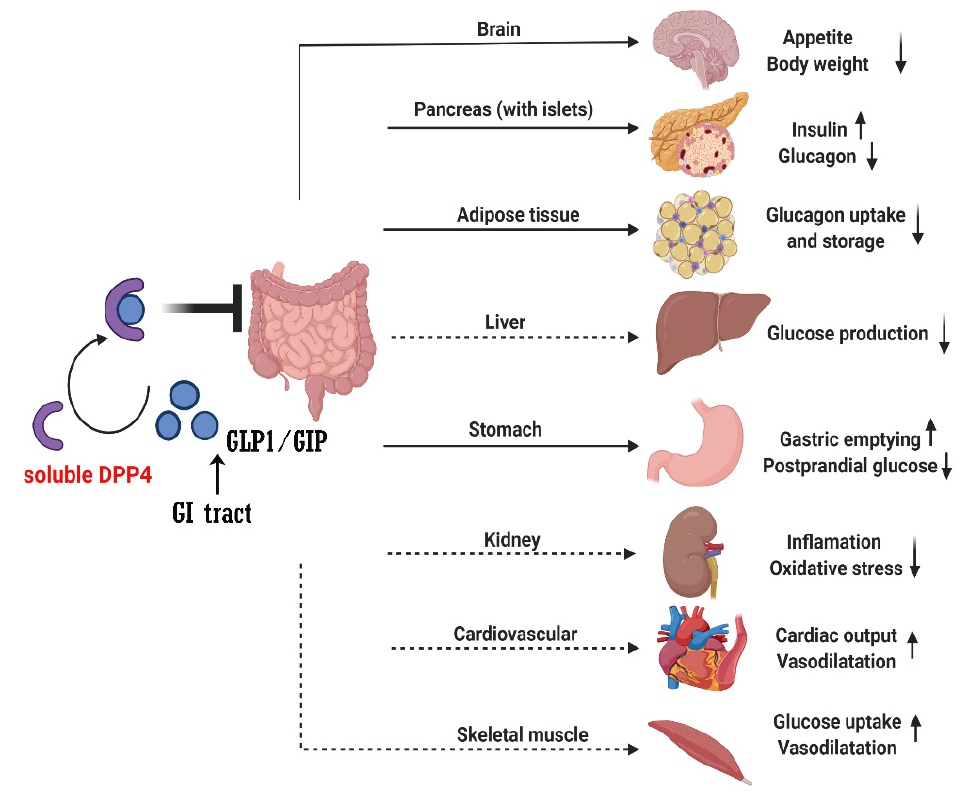
Figure 1. The action of DPP4 degrades the GLP1 and GIP. GI: gastrointestinal; GIP: glucose-dependent insulinotropic polypeptide, GLP1: glucagon-like peptide-1, DPP4: dipeptidyl peptidase-4. Solid arrows mean the direct regulation effects by GLP1 or GIP; dashed arrows mean the indirect regulation effects by GLP1 or GIP.